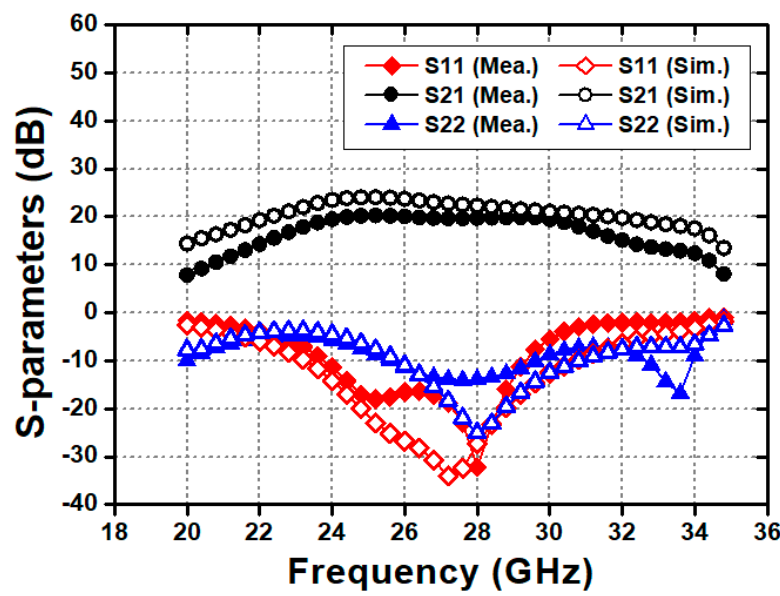
Figure 10. Measured and simulated small signal gains, S 11s and S 22s of the LNA.